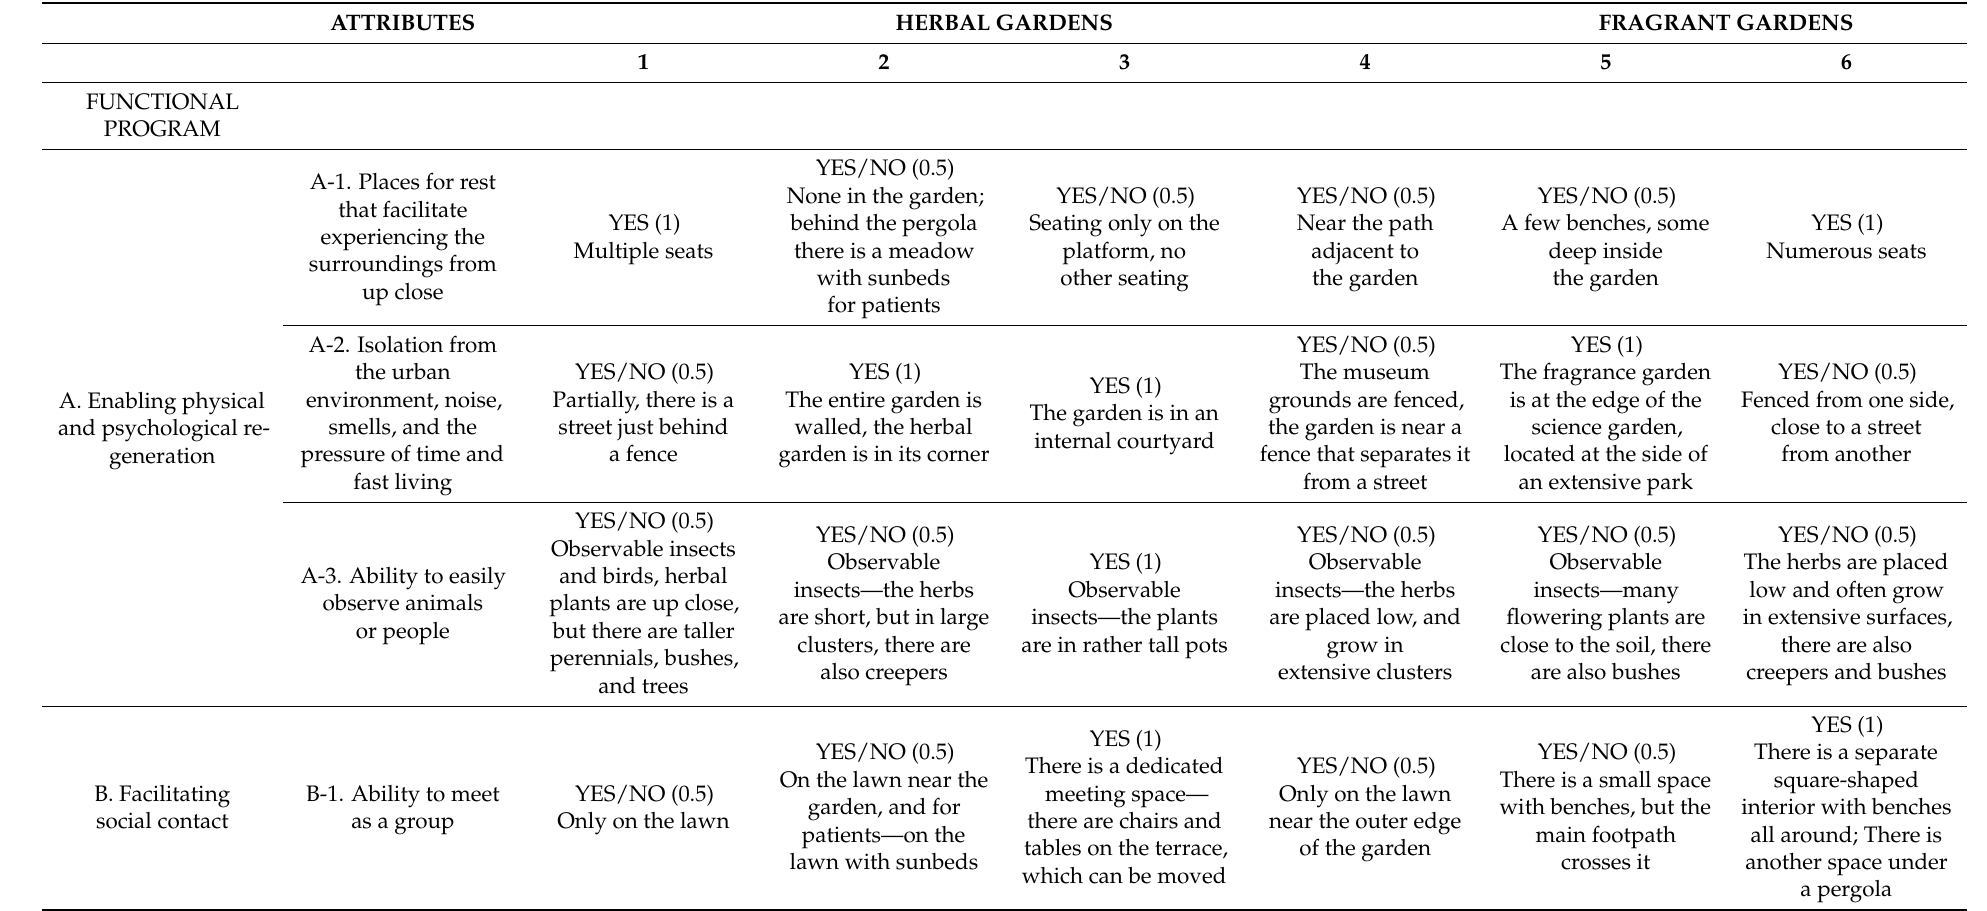
Table 5. Analysis of the therapeutic properties of herbal gardens with sensory features, part 1—functional